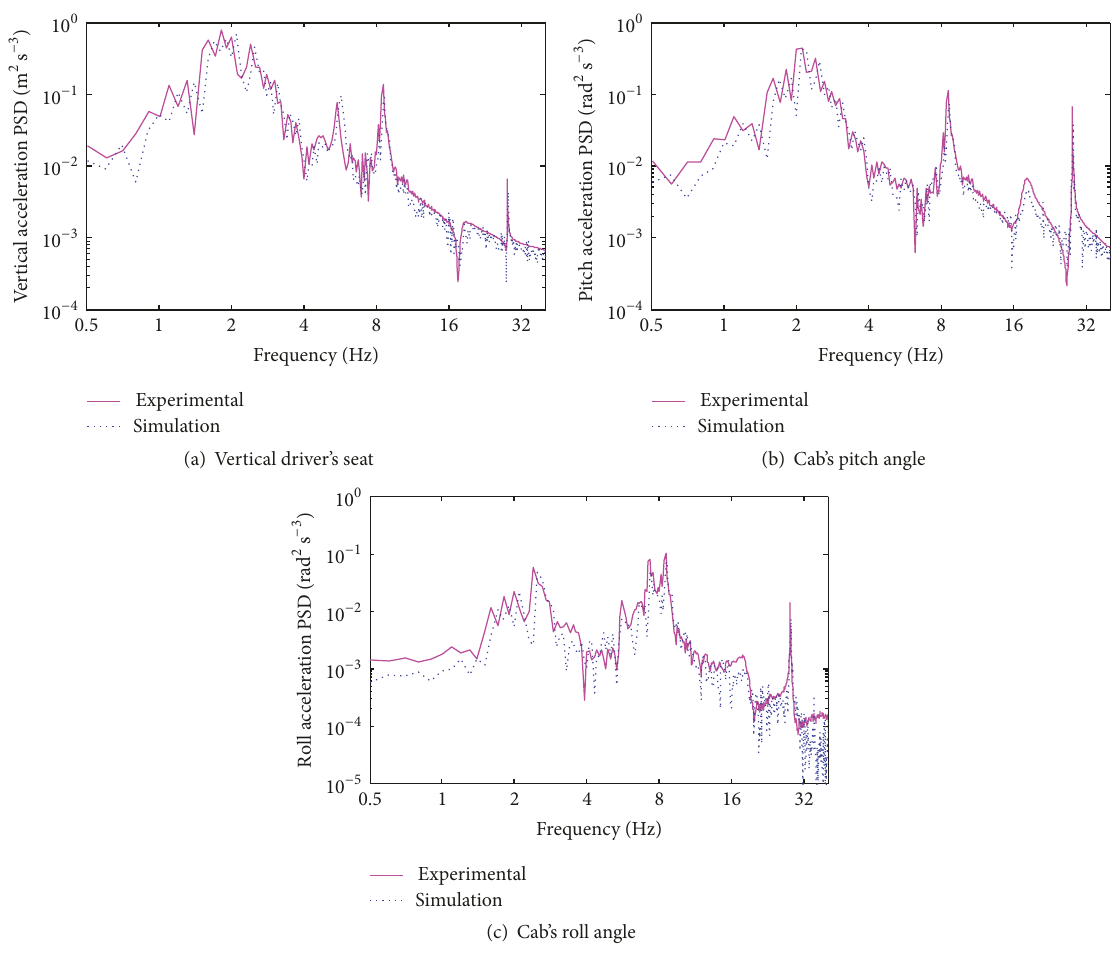
Figure 8: The acceleration PSD responses under a low excitation frequency 28 Hz of the